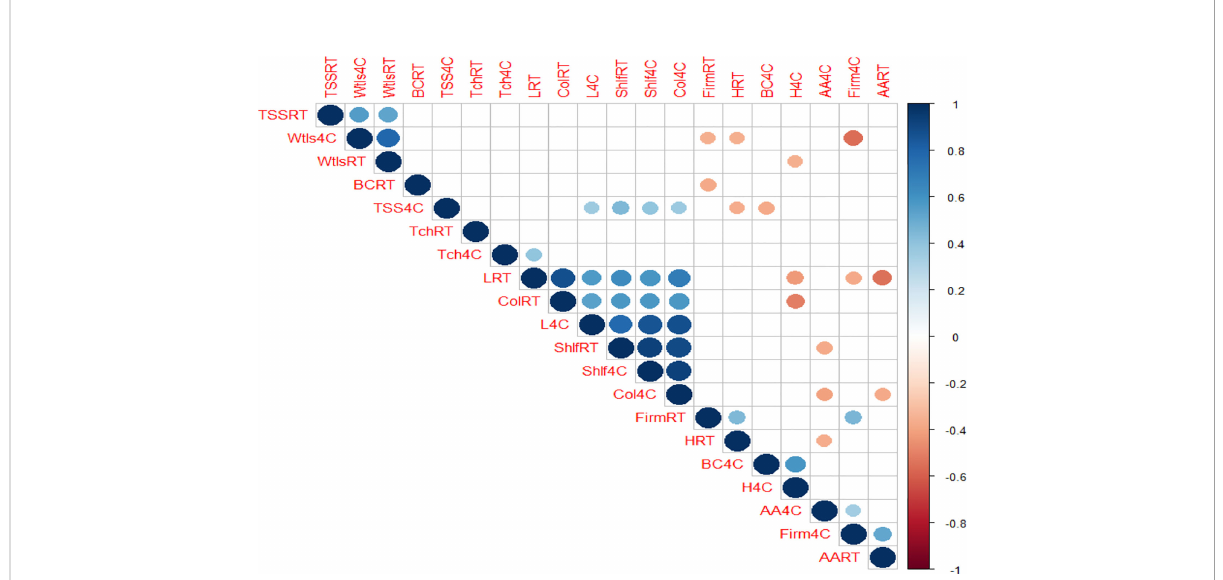
FIGURE 1 Correlation matrix in between and among physiochemical, colorimetric, and nutritional parameters studied for pointed gourd quality storage. Shlf, shelf-life; Firm, fi rmness; Wtlos, weight loss; TSS, total soluble solid; Tch, total chlorophyll; L, lightness; H, hue; Col, chroma; AA, ascorbic acid; BC, b -carotene; 4C, refrigerated at 4°C at 45% RH; RT, room temperature 30 ± 2°C at 65 – 75% RH.